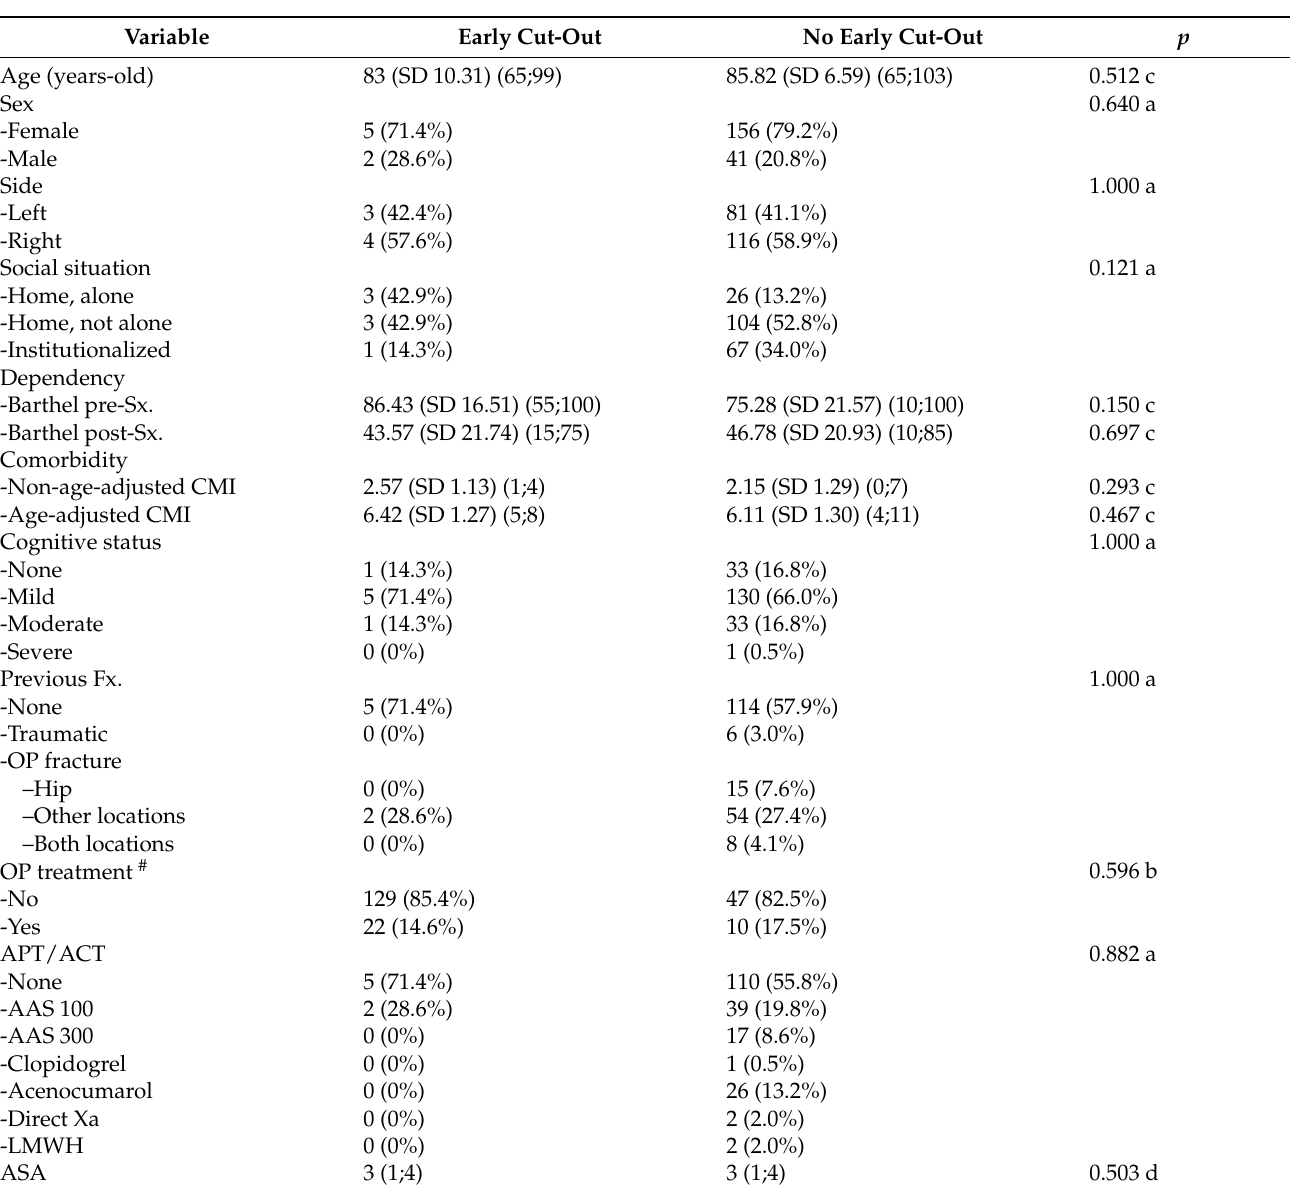
Table 1. Preoperative variables. Tests: a, Fisher’s exact test; b, Pearson’s chi-square test; c, Mann– Whitney’s U test; d, median test (Sx., surgery; CMI, Charlson’s comorbidity index; OP, osteoporosis; Fx., fracture; APT, anti-platelet therapy; ACT, anti-coagulation therapy; AAS, acetylsalicylic acid; LMWH, low-molecular-weight heparin; ASA, American Society of Anesthesiologists). # Upon admission, no calcium and/or vitamin